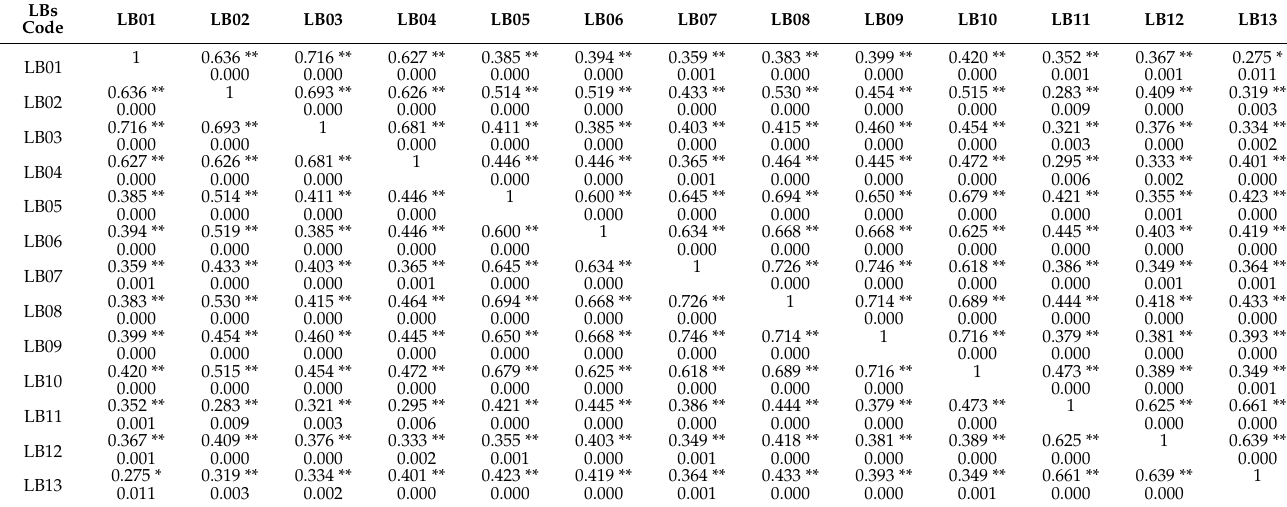
Table 3. Pearson’s bi-variate two-tailed